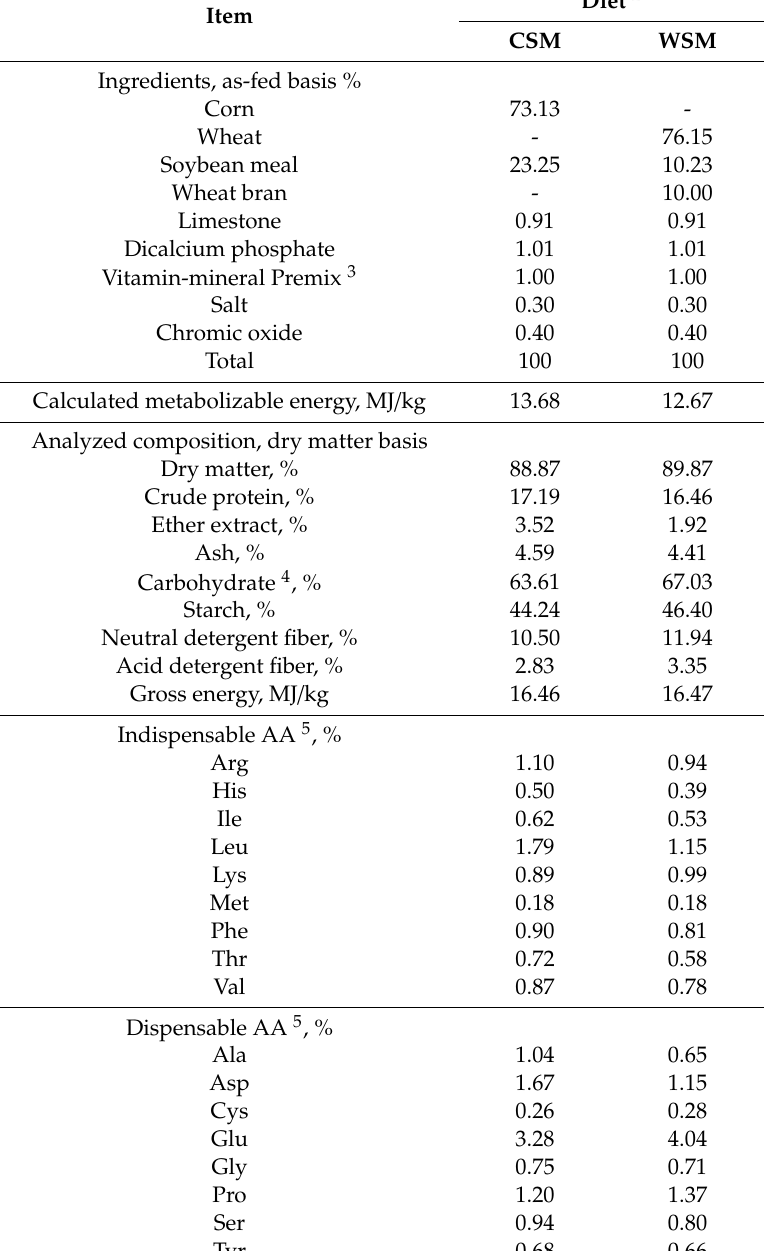
Table 2. Ingredients and analyzed nutrient composition of experimental basal diets 1 .